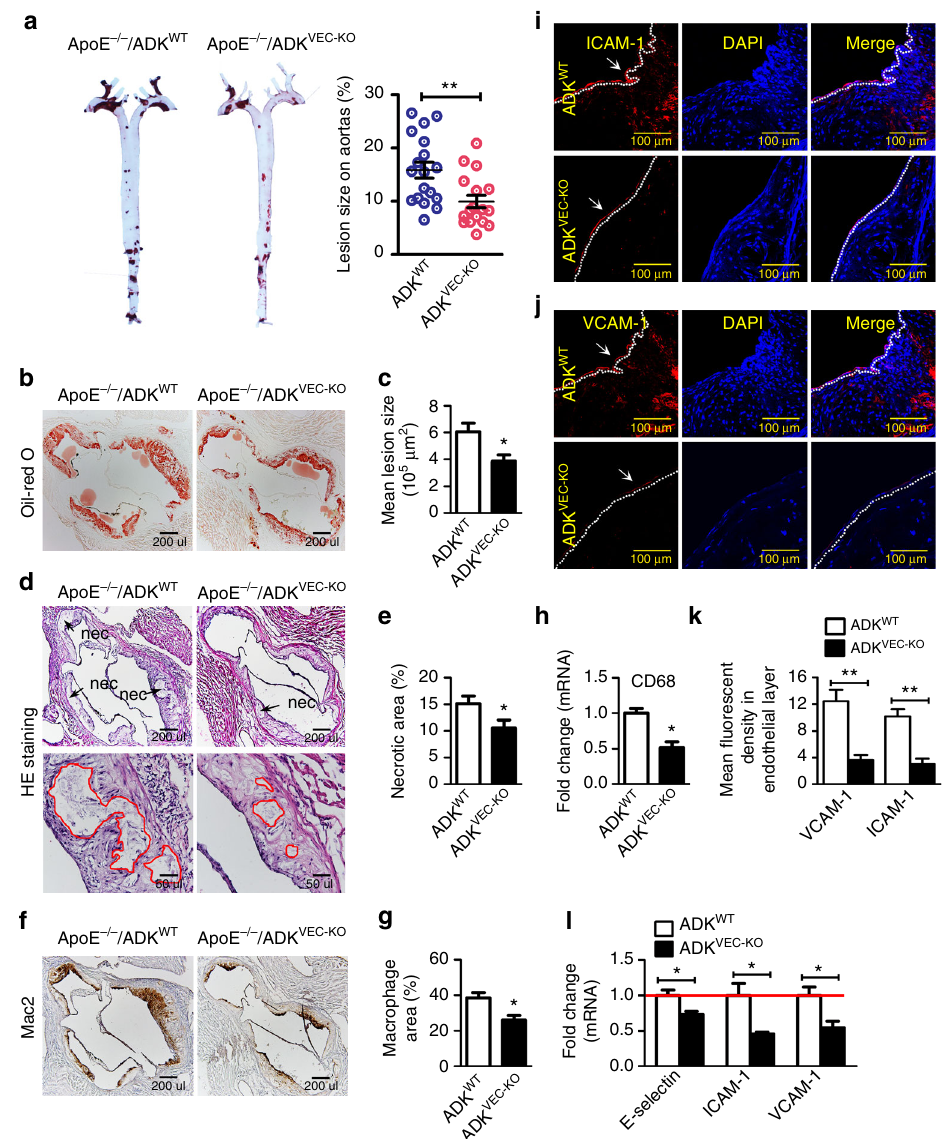
Fig. 6 Endothelial-speci fi c ADK de fi ciency prevents atherogenesis. a Oil Red O-stained en face aortic preparations from ApoE − / − /ADK WT and ApoE − / − /ADK VEC-KO mice and quanti fi cation of the Oil Red O-stained areas ( n = 16 – 18 mice per group). b , c Oil Red O staining of aortic roots and quanti fi cation of lesion area in aortic roots of ApoE − / − /ADK WT and ApoE − / − /ADK VEC-KO mice ( scale bar : 200 µ m for b ; n = 6 mice per group). d , e HE staining of aortic roots and quanti fi cation of necrotic areas in aortic roots of ApoE − / − /ADK WT and ApoE − / − /ADK VEC-KO mice ( scale bar : 200 µ m for upper images and 50 µ m for lower images ; n = 6 mice per group). Red lines show the boundary of necrotic cores. f – h IHC staining of Mac2 ( f ; scale bar : 200 µ m), quanti fi cation of Mac2 + areas in aortic roots ( g , n = 6 mice per group), and RT-PCR analysis of mRNA levels of CD68 ( h , n = 5 per group) in aortic arches of ApoE − / − /ADK WT and ApoE − / − /ADK VEC-KO mice. i – k Immuno fl uorescent staining of ICAM-1 ( i ; scale bar : 100 µ m) and VCAM-1 ( j ; scale bar : 100 µ m) in aortic roots, and quanti fi cation of ICAM-1 and VCAM-1 expression in endothelial layer in aortic roots from ApoE − / − /ADK WT and ApoE − / − /ADK VEC-KO mice ( k , n = 6 mice per group). l RT-PCR analysis of mRNA levels of adhesion molecules in aortic arches of ApoE − / − /ADK WT and ApoE − / − /ADK VEC-KO mice ( n = 5 mice per group). All images are representative. For all bar graphs , data are the mean ± SEM, * P < 0.05 and ** P < 0.01 (Unpaired, two-tailed Student ’ s t